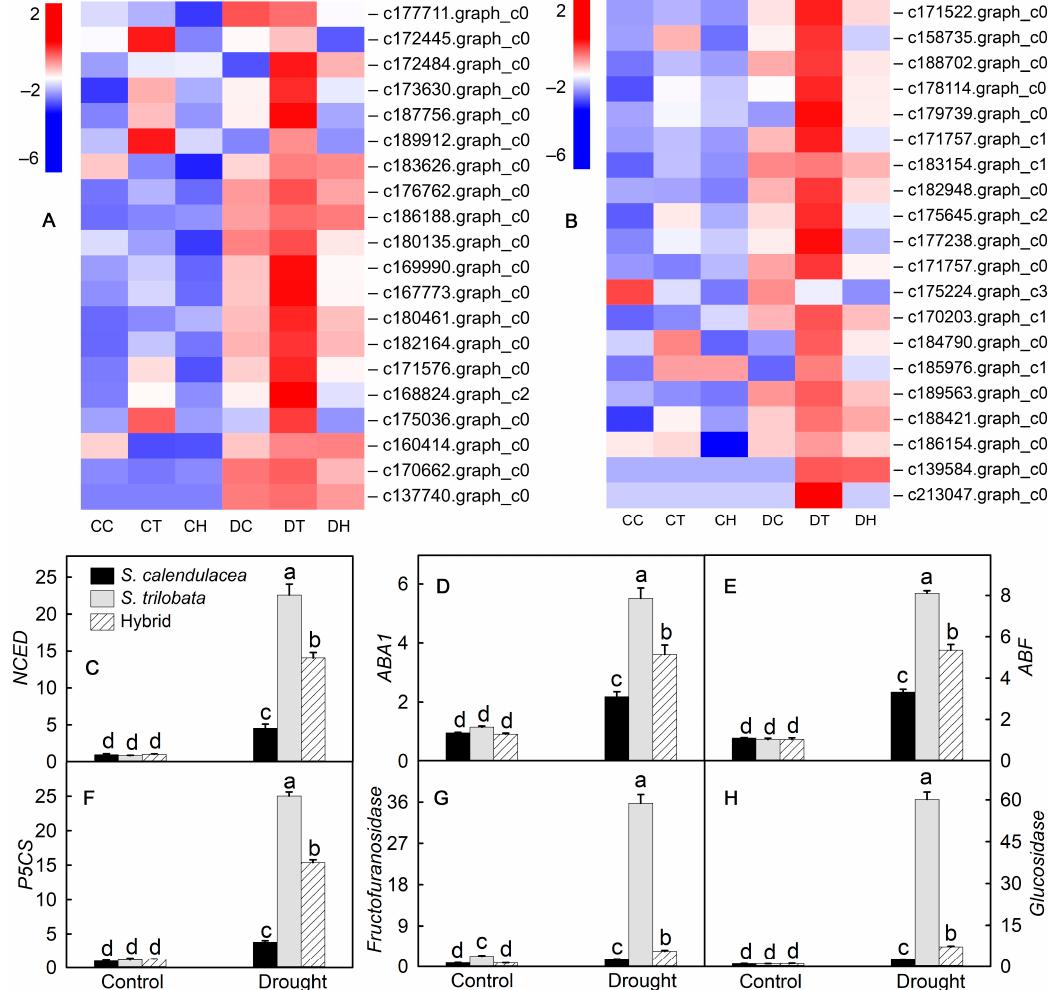
Figure 5. Heatmap of gene expression and results of real-time PCR validation. Heatmap of genes related to abscisic acid ( A ), sugar and proline ( B ) synthesis and the results of real-time PCR validation ( C – H ) under normal irrigation (control) and drought treatment (drought) in leaves of S . calendulacea , S . trilobata and their hybrid. Different lowercase letters (a, b, c, d) above bars indicate statistical significance ( p < 0.05). CC: control of S. calendulacea ; CT: control of S. trilobata ; CH: control of the hybrids; DC: drought stress treatment of S. calendulacea ; DT: drought stress treatment of S. trilobata ; DH: drought stress treatment of the hybrids.